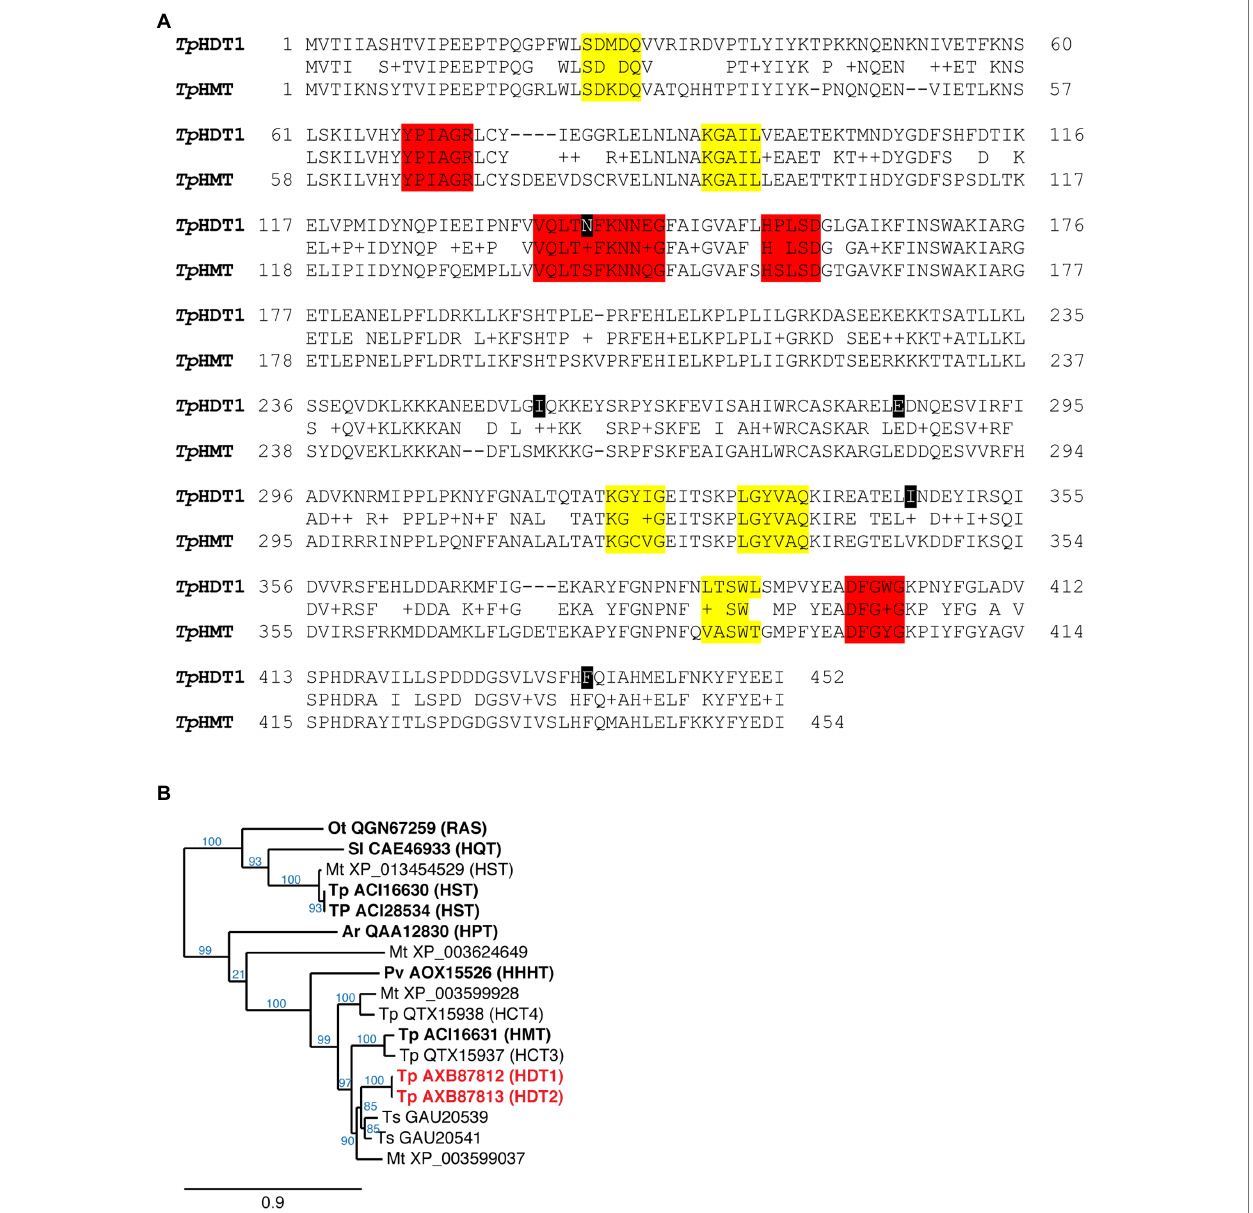
caffeoyl-L-Tyr (peak g; Figure 4B and Table 6 ). A very minor peak at approximately 12.0 min (peak m) was consistent with feruloyl-L-DOPA based on retention time, λ max , and MS signal.